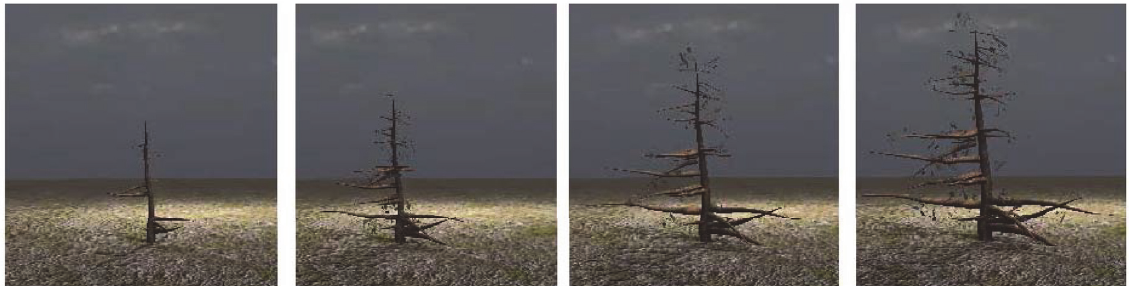
Figure 15: Four states of one tree in growth in Unity3D software. Each model must be set manually, and some branches maybe appear suddenly as the discrete setting environment in Unity3D. Referring to Figure 10, our TomatoVis system can generate the models continually without any special settings for any growth